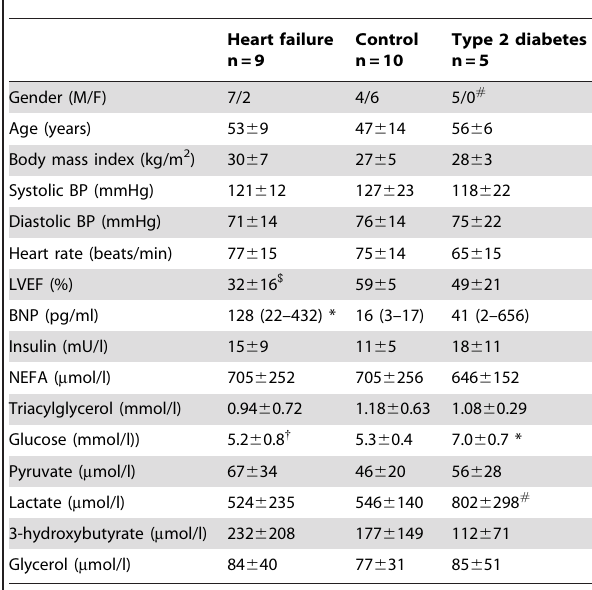
Table 1. Baseline description of heart failure, control and type 2 diabetes